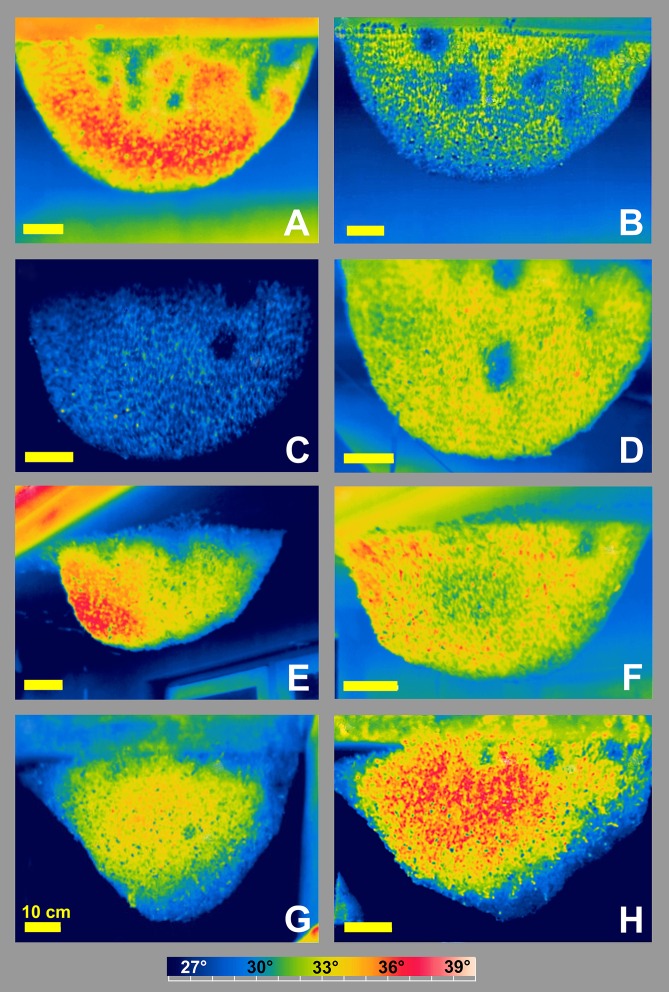
Apis dorsata nests (Chitwan, Nepal) with cool nest regions (CNRs).(A-B) Experimental “nest 01” recorded at 3:16 pm and 2:11 pm under strong solar irradiation revealing 6–8 CNRs; (C-D) “nest 02”, morning aspect (10:15 am) with four CNRs, and afternoon aspect (4:12 pm); (E-F) “nest 03”, exposure to direct sunlight from the left at 1:11 pm and 4:12 pm; (G-H) two days old colony cluster, late morning aspect at 11:05 am and at 1:22 pm under strong solar irradiation. Horizontal yellow bars indicate 10 cm; bottom bar, rainbow-900 temperature scale (26°- 40°C).